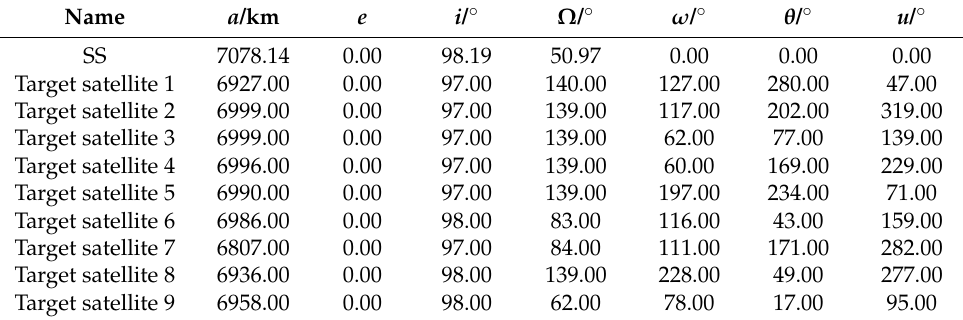
Table 4. SS and target satellite orbit parameters of example 2.